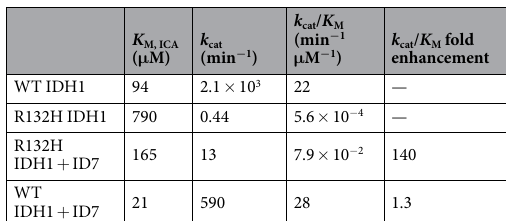
Table 1. Thermodynamic and kinetic parameters for the enhancement of IDH1 mutant activity by ID7